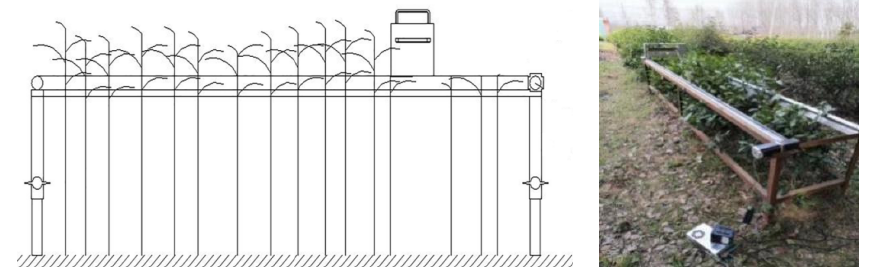
Figure 9. Structure and field application of cutting test system.